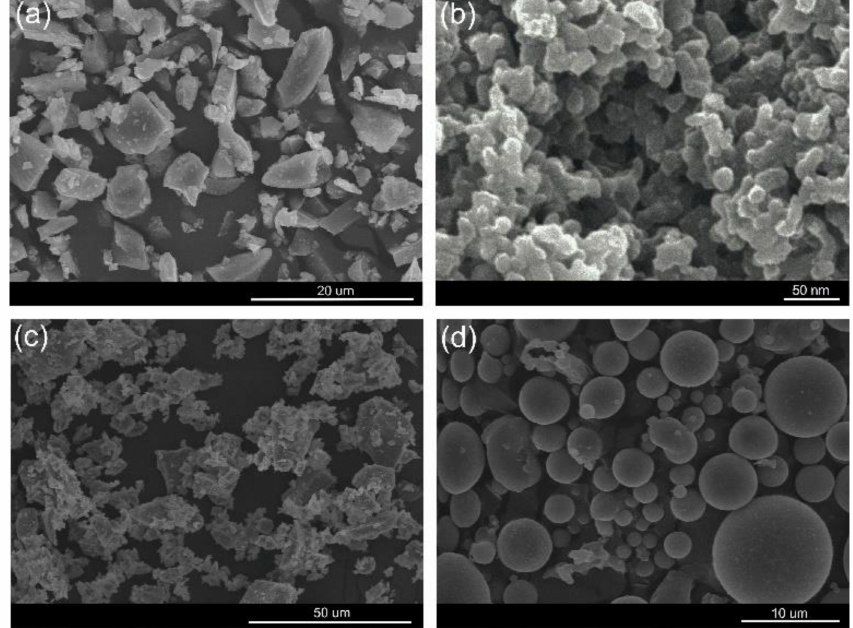
Figure 1. Scanning electron microscopy (SEM) micrographs of ( a ) micro-Al 2 O 3 ( b ) nano-Al 2 O 3 , ( c ) cement particles and ( d ) fly ash.